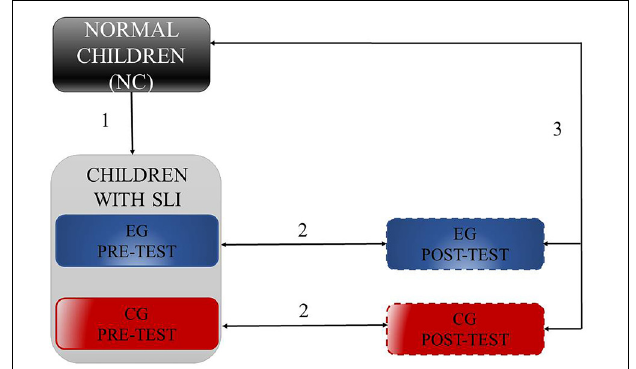
FIGURE 4 | Schema of performed comparisions in Steps 1–3, where (1) reflects camparisons of phonetic identification between NC and SLI, (2) training-related differences in EG and CG, and (3) post-test performance in EG and CG in comparison to